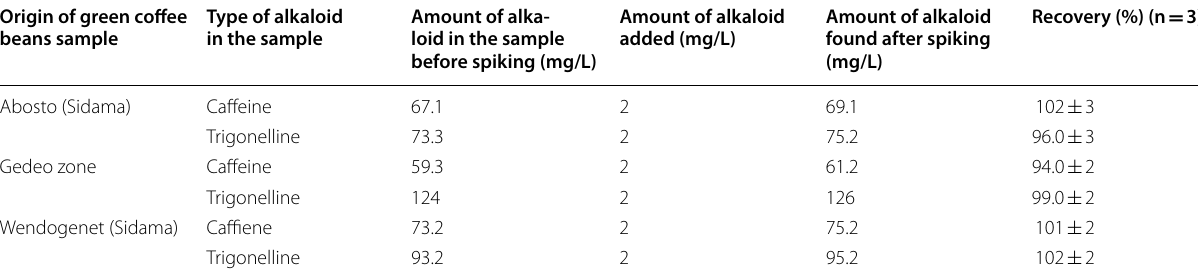
Table 2 Recovery results of caffeine and trigonelline by the developed fluorescence method Origin of green coffee beans sample